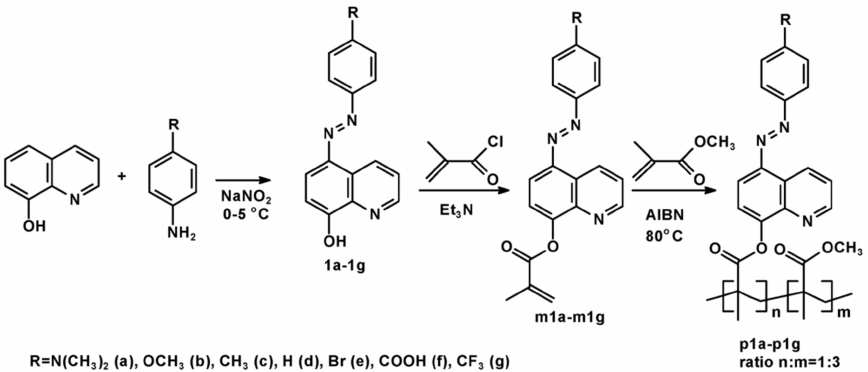
Figure 10. Synthesis of azo-quinoline containing polymers with various electron donating and electron withdrawing substituents.